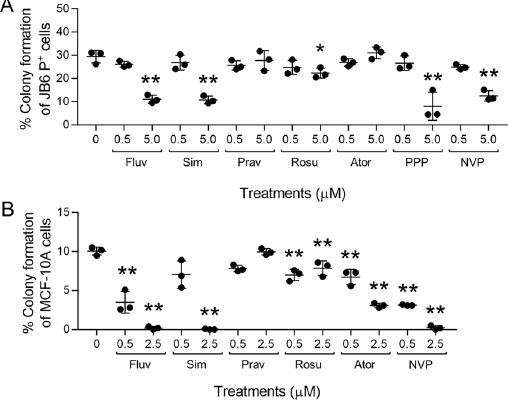
Figure 4. IGF1R inhibitors prevent FGF2-stimulated transformation whereas efficacy of HMG-CoA reductase inhibitors varies. ( A ) Fluvastatin (Fluv), simvastatin (Sim), rosuvastatin (Rosu), PPP, and NVP-ADW742 (NVP) significantly attenuated FGF2 (5 ng/mL)-stimulated transformation of JB6 P + cells (2,000 cells/well) at 5.0 µ M. Colonies were counted via automated counting using the Cytation 3 imaging reader from Biotek using Gen5 3.04 software. Seven pictures were taken every 100 microns and superimposed together by the zprojection function. ( B ) Fluvastatin (Fluv), rosuvastatin (Rosu), atorvastatin (Ator), and NVP-ADW742 (NVP) significantly attenuated FGF2 (30 ng/mL)-stimulated transformation of MCF-10A cells (1,000 cells/well) at 0.5 and 2.5 µ M. Simvastatin (Sim) was significant at 2.5 µ M. Each treatment group had three replicates and analyzed by one-way ANOVA with multiple comparisons ( * p < 0.05; ** p <